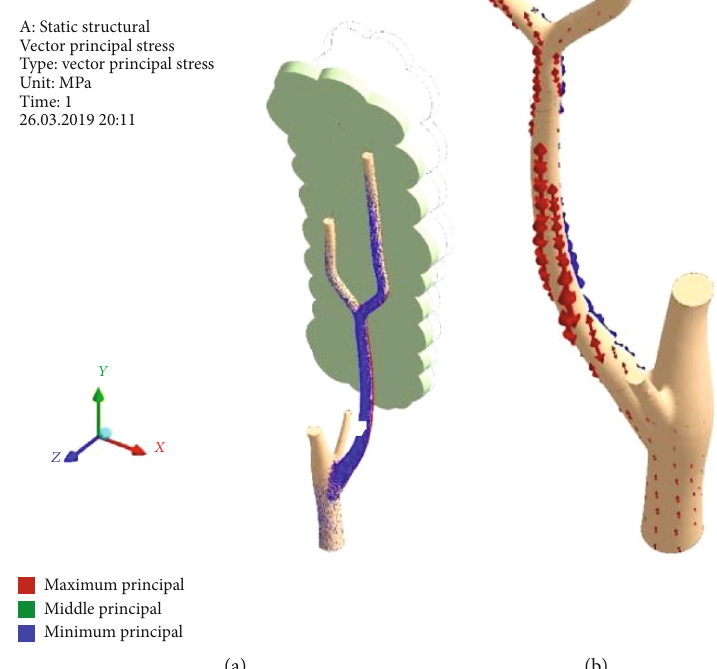
Þ = 380 ; RectCrown, × 1. norm